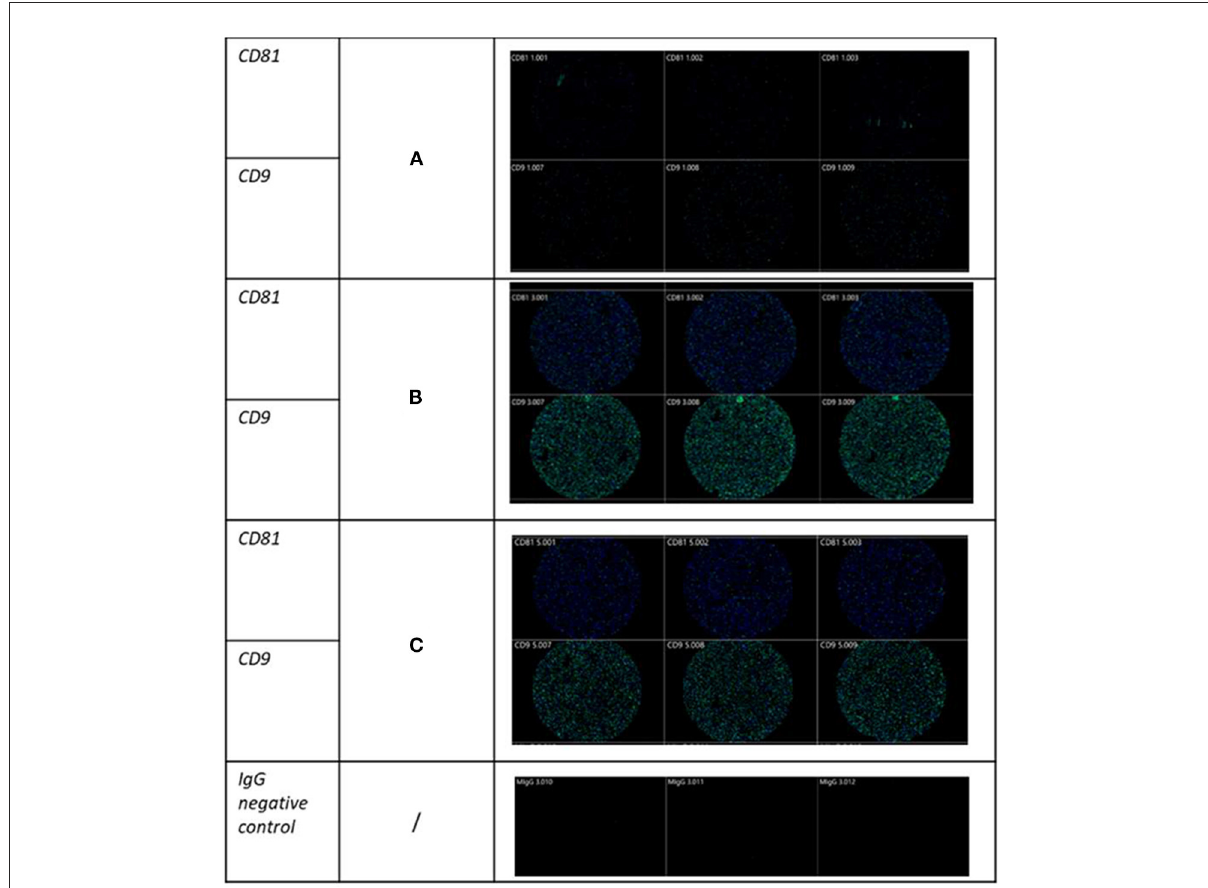
FIGURE3 Visualization of SF-derived EVs from control, osteoarthritic (OA) and OA + MSCs joints using Exoview at selected time points. A fluorescent image of a representative spot is shown for each sample comparing (A) control, (B) OA, and (C) OA + MSCs with color denoting surface tetraspanin positive identification (blue-CD9, and